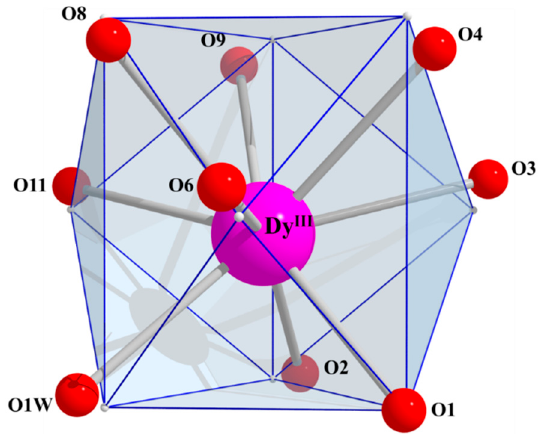
Figure 3. The spherical tricapped trigonal prismatic coordination polyhedron of the Dy III center in complex 7 · MeCN_Dy. The smaller cream spheres define the vertices of the ideal polyhedron.